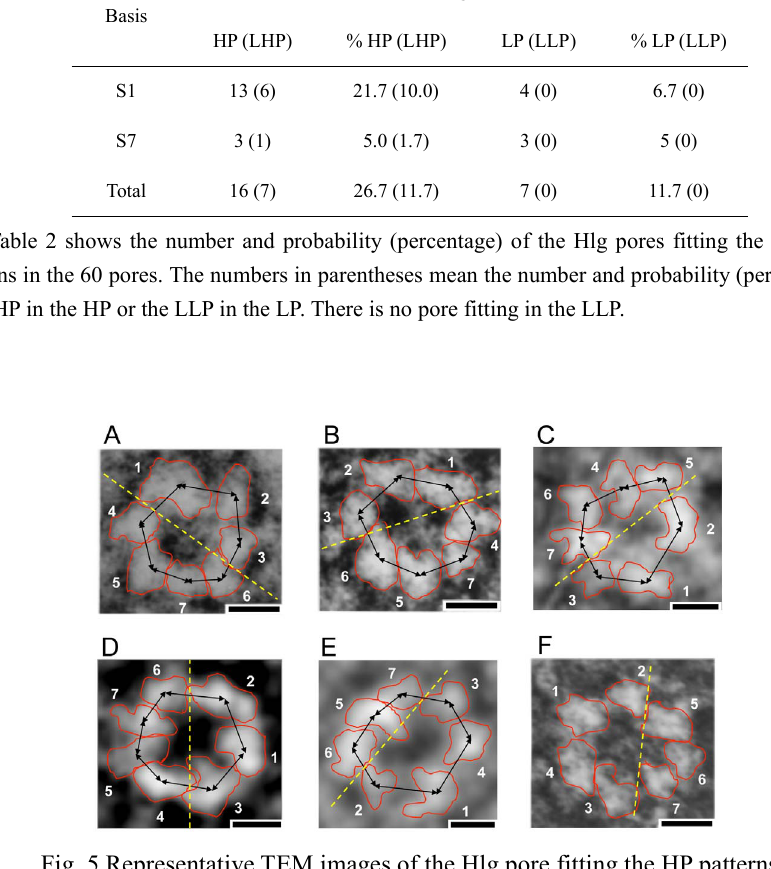
Table 2 Probability of the HP and the LP patterns in the Hlg pore